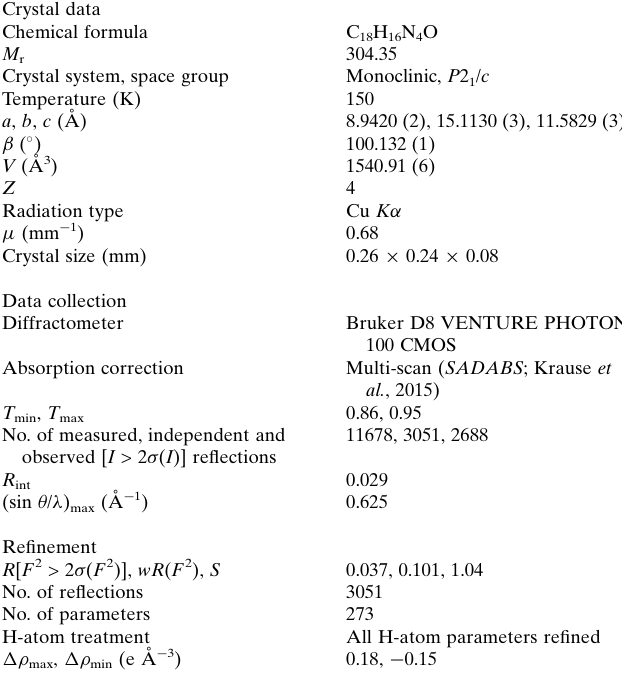
Crystal data Chemical